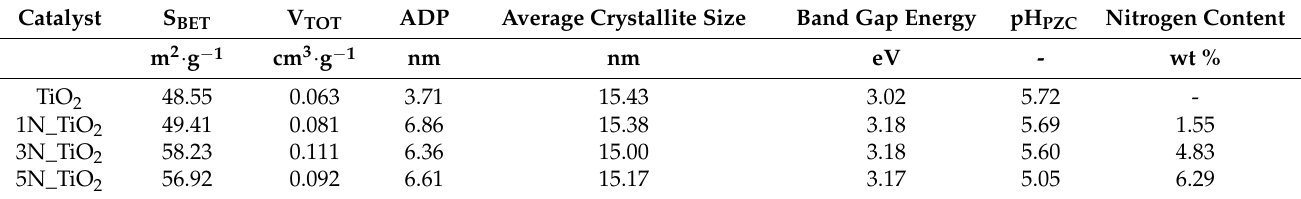
Figure 1. XRD patterns of undoped TiO 2 and nitrogen-doped TiO 2 used in this study. Table 1. Physicochemical characterization of TiO 2 and nitrogen-doped TiO 2 .